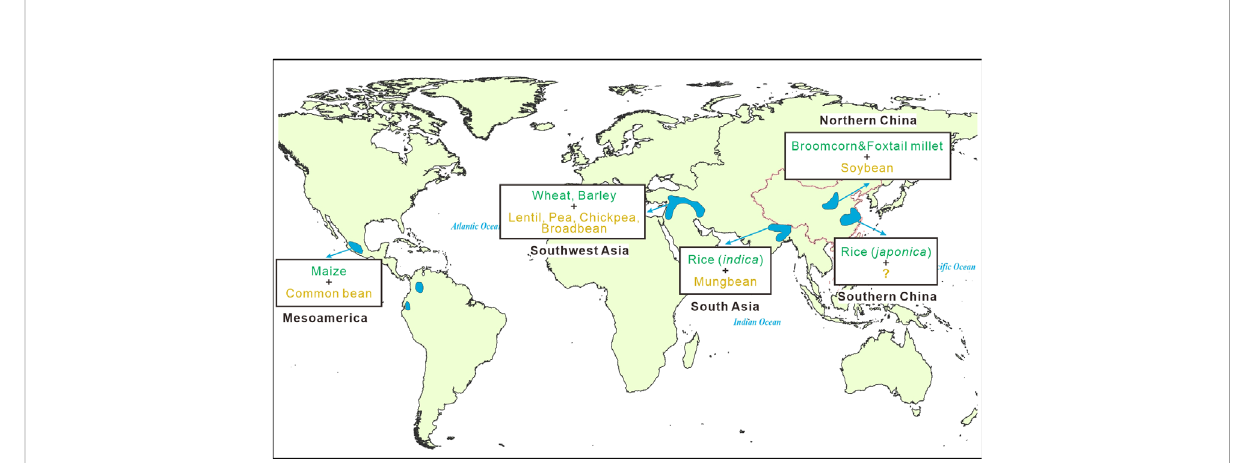
FIGURE 1 Staple cereals and companion legumes in the centers of plant domestication (Larson et al.,